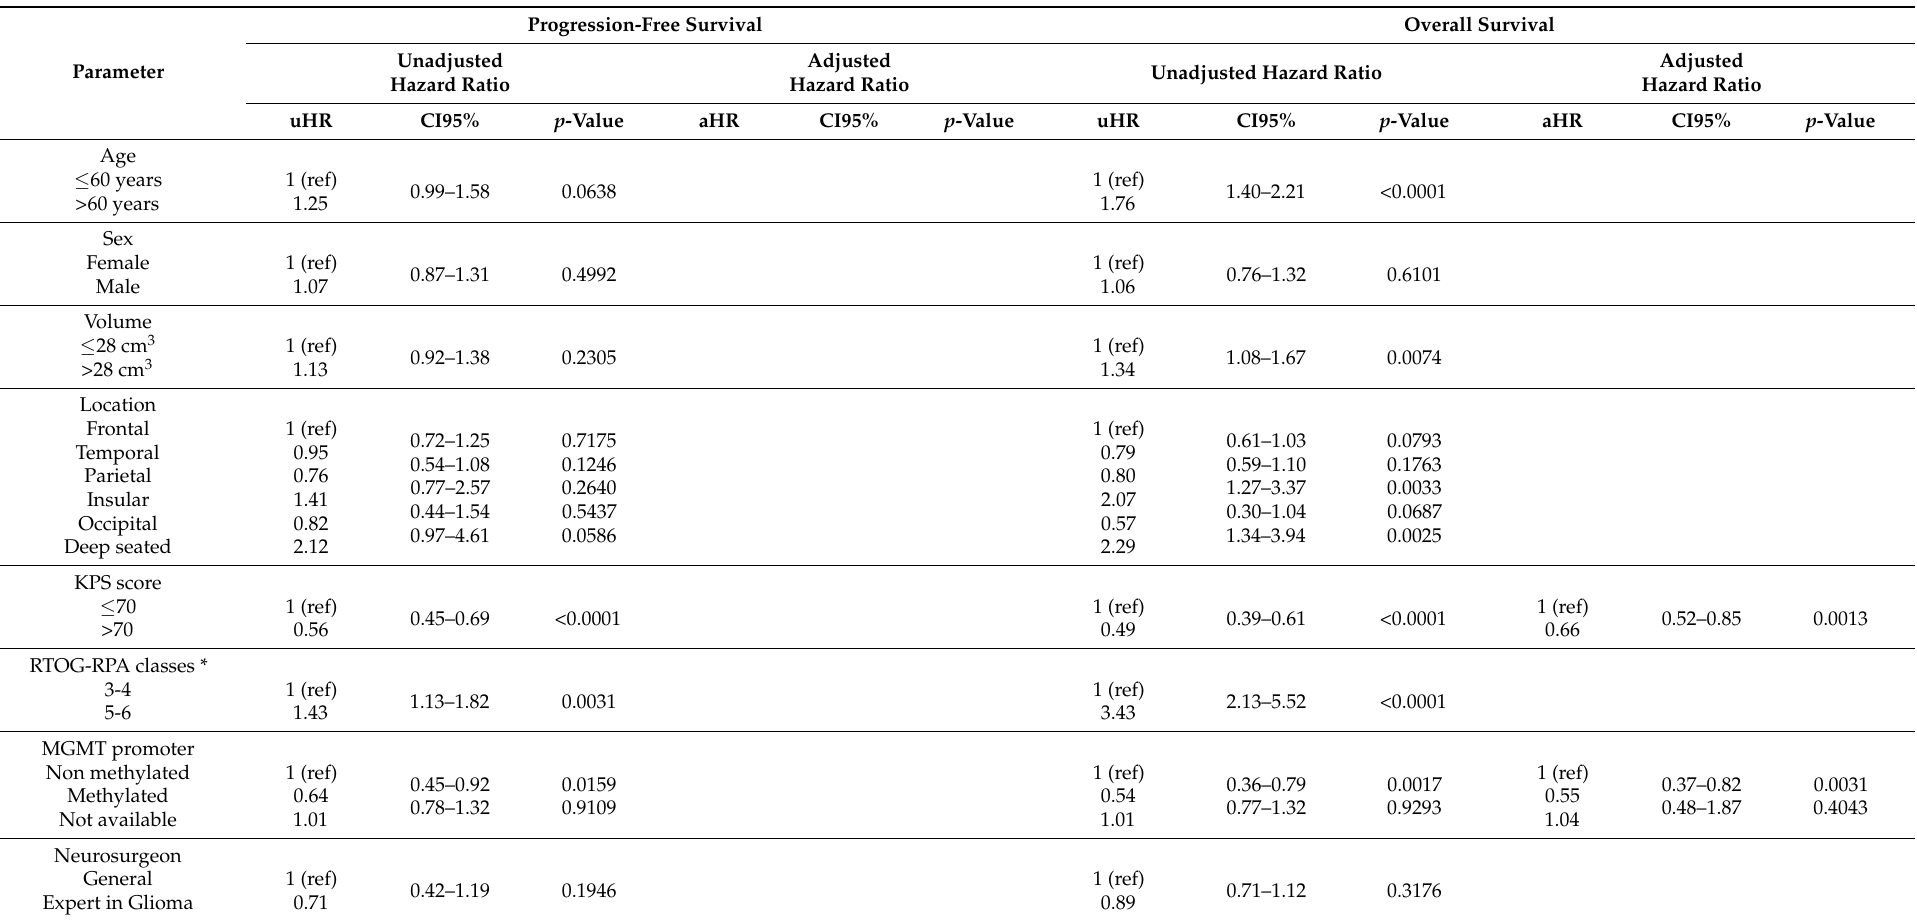
Table 3. Univariate and multivariate predictors of progression-free survival and overall survival in the whole series ( n = 434). Unadjusted hazard ratios by log-rank tests and adjusted hazard ratios by Cox proportional hazards